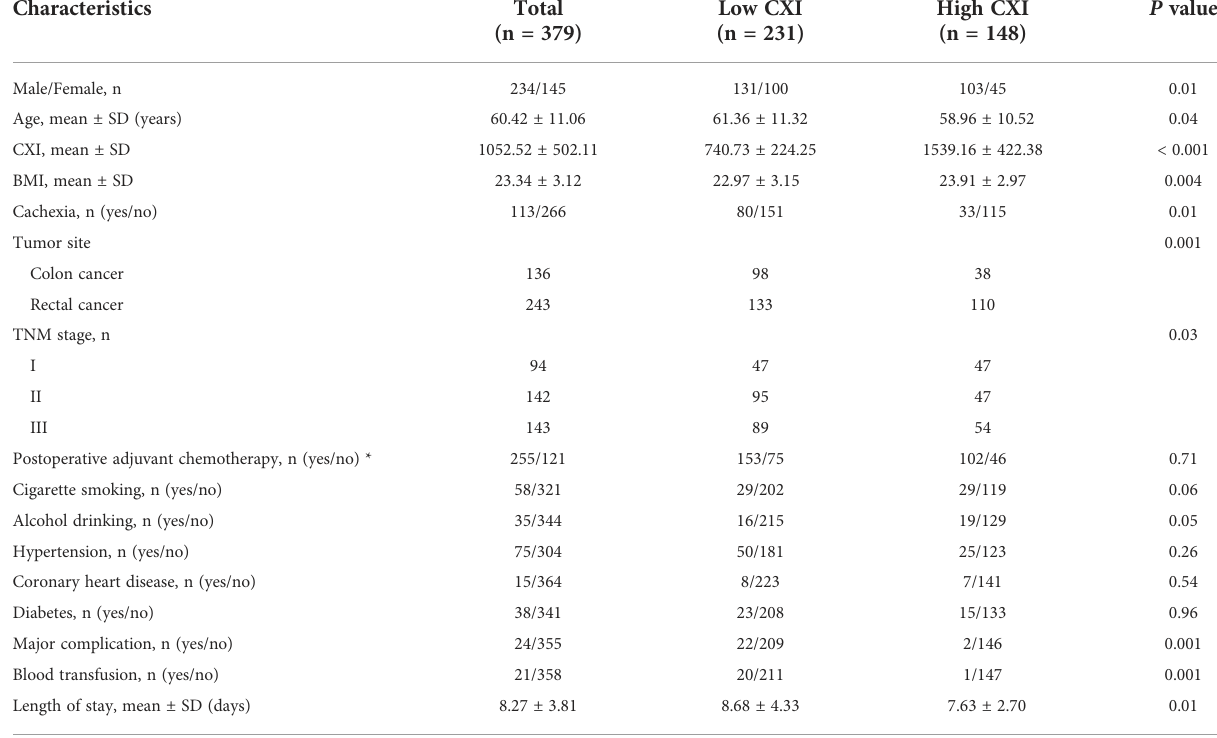
TABLE 1 Comparison of the clinical characteristics between patients in low and high CXI groups.